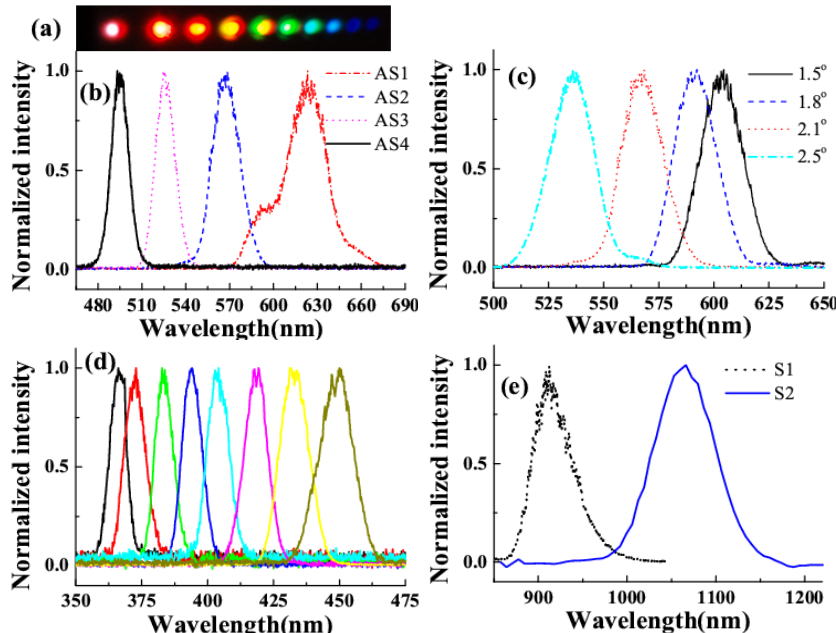
Figure 4. (a) Photograph of sidebands on a sheet of white paper 1 m after the glass plate. (b) The spectra of the sidebands from AS1 to AS4 when the crossing angle was 2.1º.